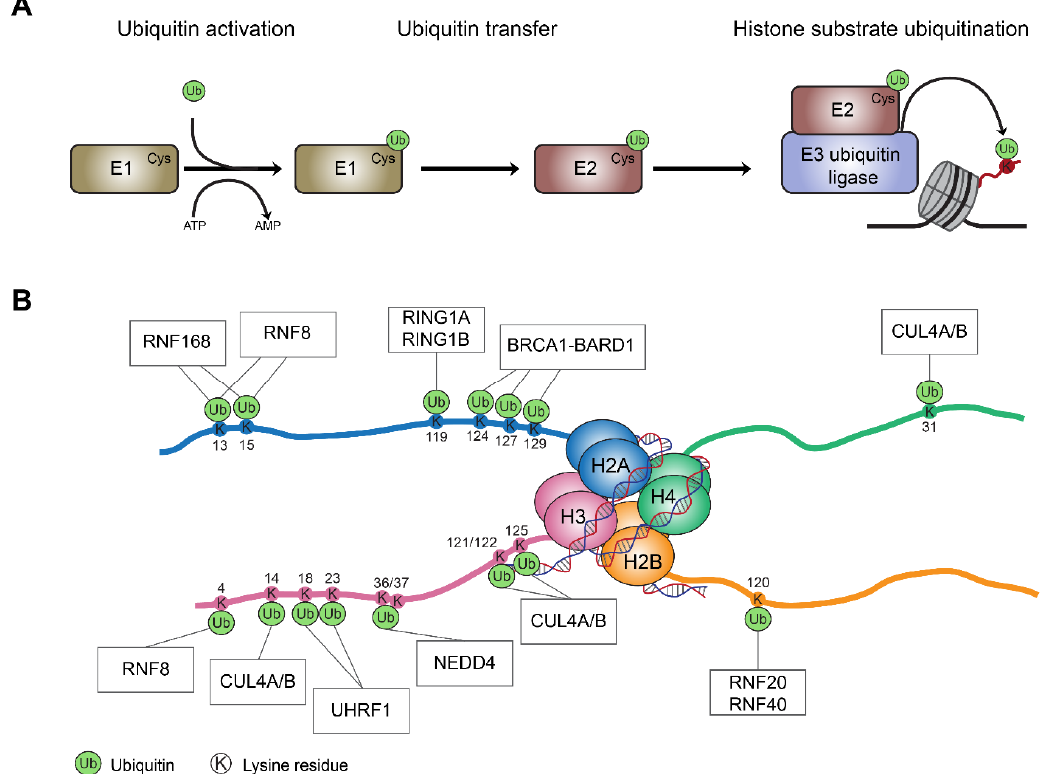
Figure 1. E3 ubiquitin ligases and histone ubiquitination events. ( A ) The process of histone mono- ubiquitination. Ubiquitin is first attached to E1 enzyme and activated in an ATP-dependent manner. Next, activated ubiquitin is transferred to E2 enzyme. Finally, E2 interacts with an E3 ubiquitin ligase that covalently attaches the ubiquitin to a target lysine residue in the histone. ( B ) A schematic representation of histone lysine (K) residues that undergo ubiquitination (Ub), and their corresponding E3 ubiquitin ligases. Mono-ubiquitination at K13 and K15 on histone H2A (H2AK13ub and H2AK15ub) placed by RNF168 are associated with DDR and DNA replication. Notably, K13 and K15 on histone H2A and K4 on histone H3 are targets for poly-ubiquitination by RNF8. Mono-ubiquitination at K119 on histone H2A (H2AK119ub) is written by RING1A/B members of the Polycomb-repressive complex 1 (PRC1). The mono-ubiquitination of K124, K127, and K129 on histone H2A (H2AK124ub, H2AK127ub, and H2AK129ub) involved in DDR, is catalyzed by the BRCA1-BARD1 complex. The mono-ubiquitination of K18 and K23 on histone H3 (H3K18ub and H3K23ub) written by UHRF1 is associated with the maintenance of DNA methylation. Mono-ubiquitination of K14, K121, K122, and K125 on histone H3 (H3K14ub, H3K121ub, H3K122ub, and H3K125ub) is catalyzed by CUL4A/B, and is involved in regulation of chromatin structure, while CUL4A/B-mediated mono-ubiquitination of K31 on histone H4 (H4K31ub) is associated with DDR. Finally, mono-ubiquitination of K120 on histone H2B by the RNF20/40 complex is associated with transcriptional